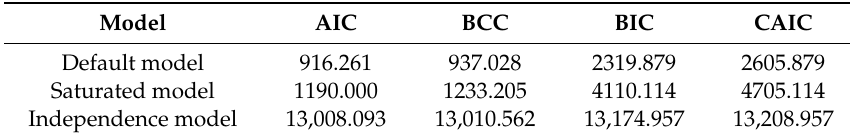
Table 6. Information on the theoretic measures of